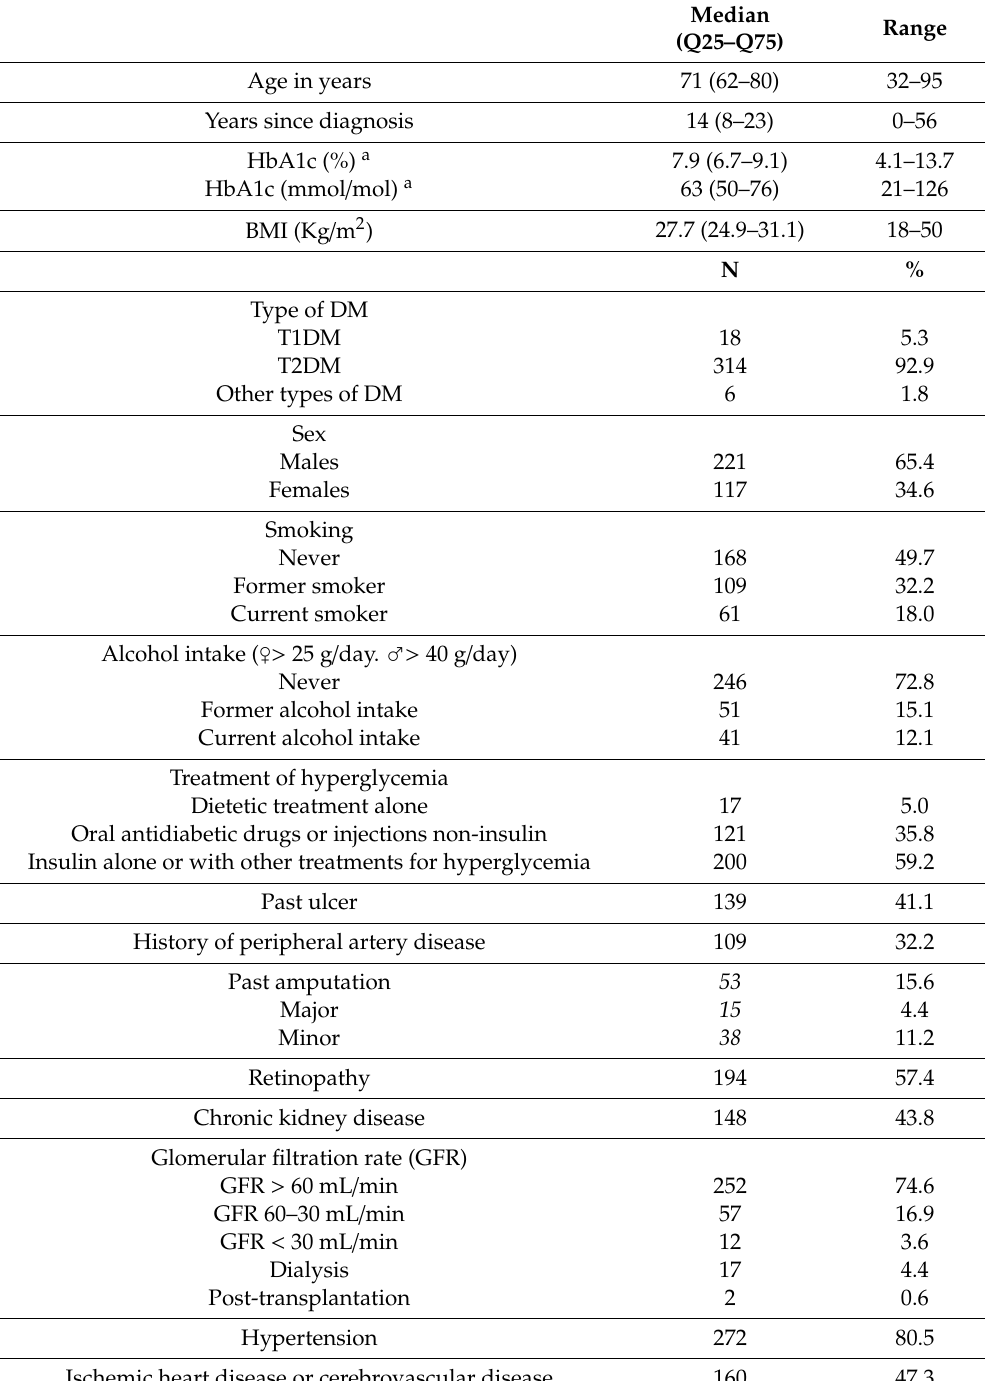
Table 1. Baseline characteristics at first outpatient presentation to the Multidisciplinary Diabetic Foot Team (MDFT) center (total cohort n = 338